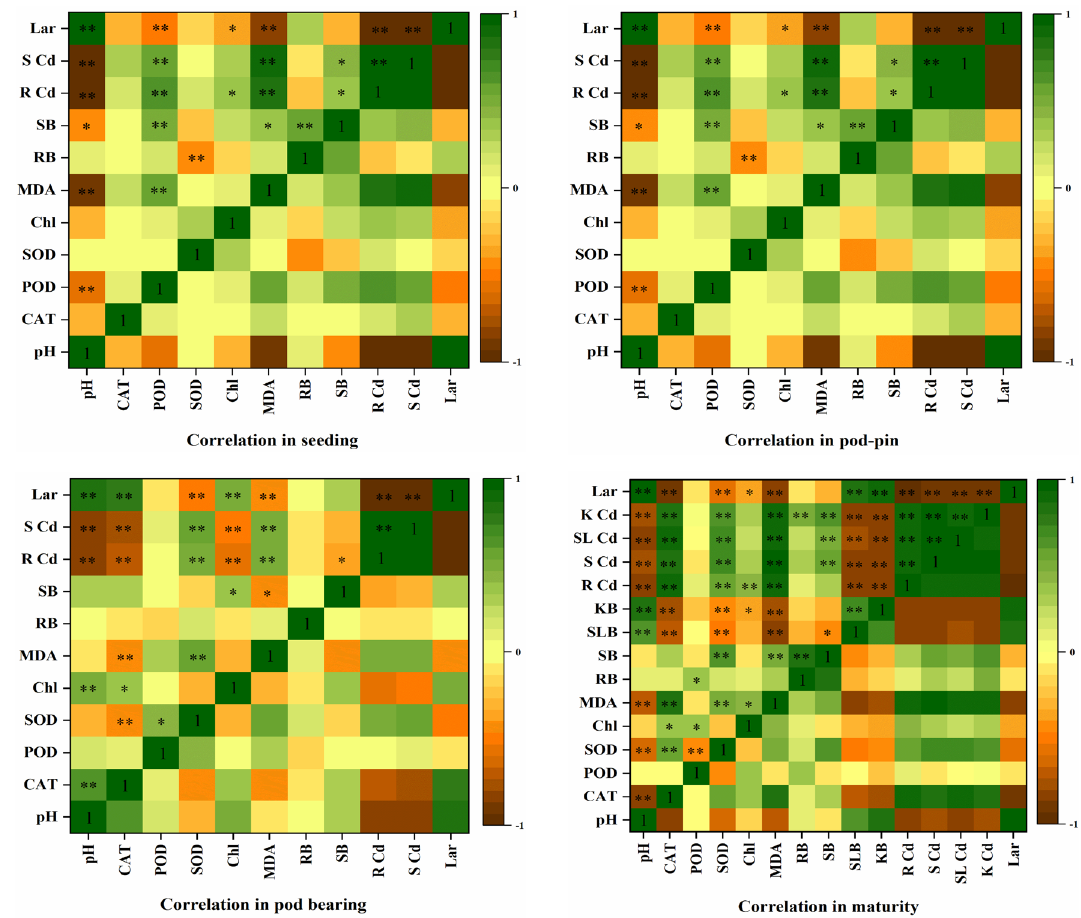
Figure 5. Correlation analysis between the indexes for peanut in the different growth stages. pH soil pH, CAT catalase contents in leaves, POD peroxidase contents in leaves, SOD superoxide dismutase contents in leaves, MDA malondialdehyde contents in leaves, RB root biomass, SB shoot biomass, SLB shell biomass, KB kernel biomass, Chl chlorophyll contents in leaves, R Cd Cd contents in roots, S Cd Cd contents in shoots, SL Cd Cd contents in shells, K Cd Cd contents in kernels, and Lar lime application rate. ** and * indicate a significant correlation at p < 0.01 and p < 0.05 levels,